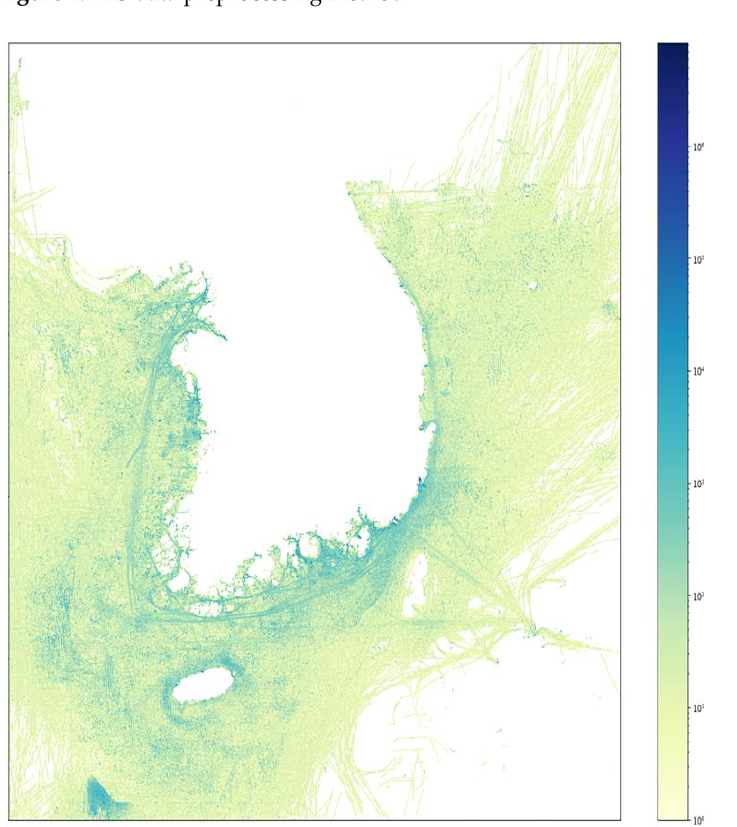
Figure 4. AIS data preprocessing method.